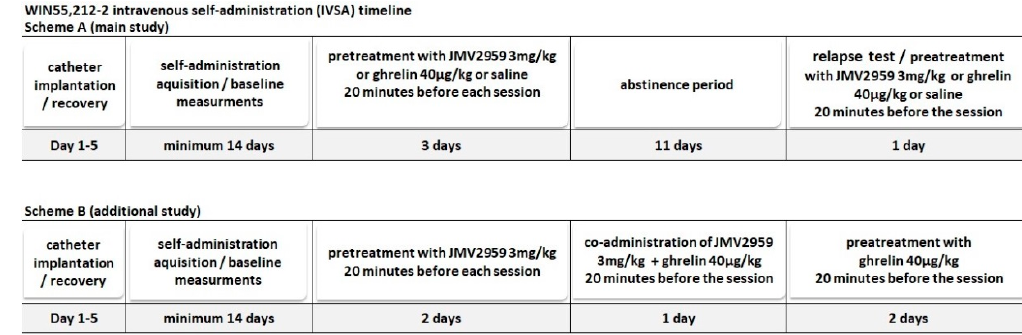
Figure 6. The time-line schedules of the IVSA experiments within the main IVSA study ( A ) and the additional IVSA study ( B ).